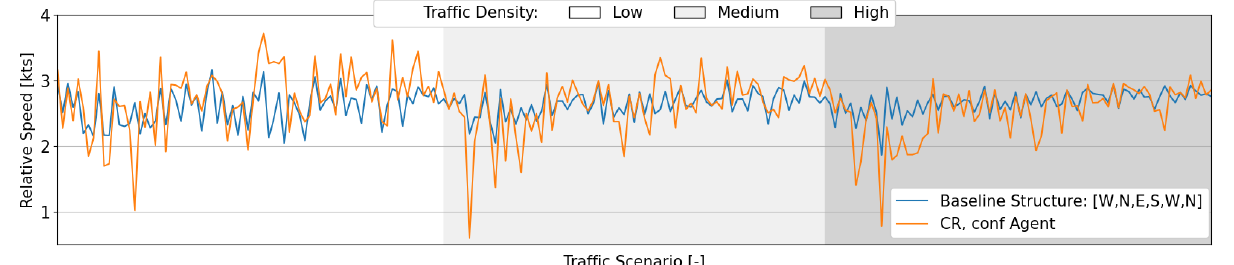
Figure 18. Mean relative speed between pairs of aircraft during LoSs with multiple layers. All traffic densities had 75 traffic scenarios, with the initial direction(s) and the number of turns following the same order as shown during the training phase.